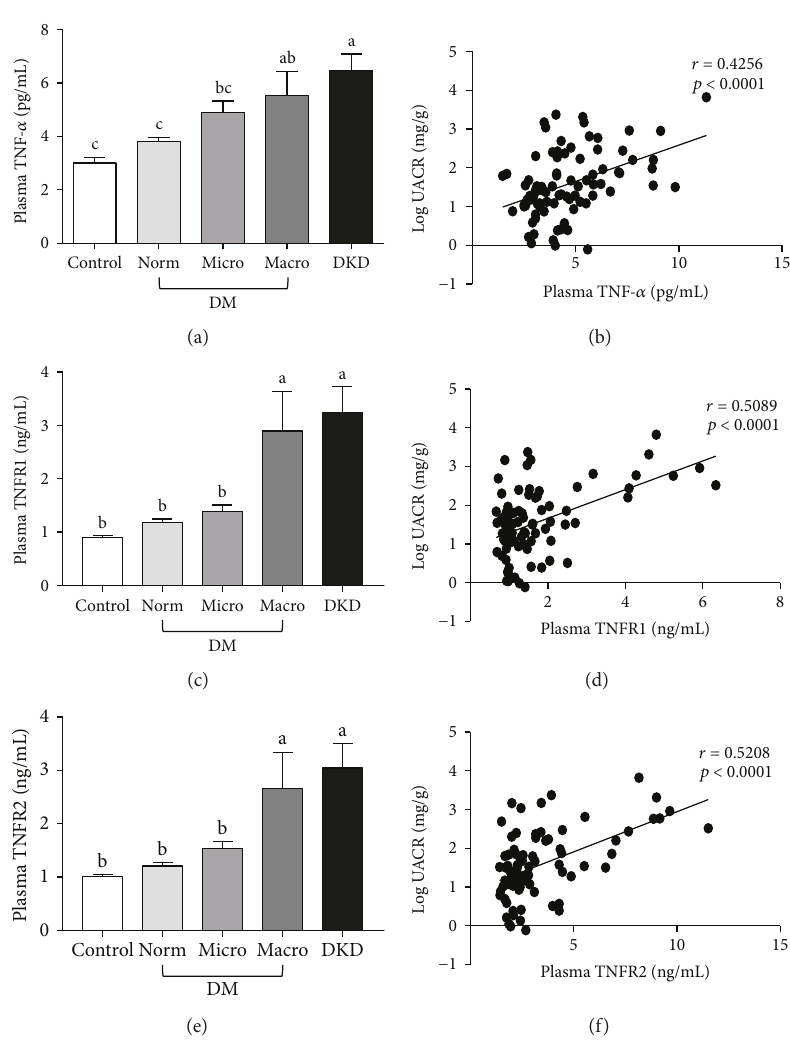
Figure 3: Plasma TNF- α (a), TNFR1 (c), and TNFR2 (e) levels in diabetic African American men, age-matched nondiabetic controls, and diabetics with diagnosed DKD. The correlation between plasma TNF- α (b), TNFR1 (d), and TNFR2 (f) and log-transformed UACR in diabetic and DKD groups. Data are represented as mean ± SEM . Labeled means without a common letter are signi fi cantly di ff erent ( p < 0 05